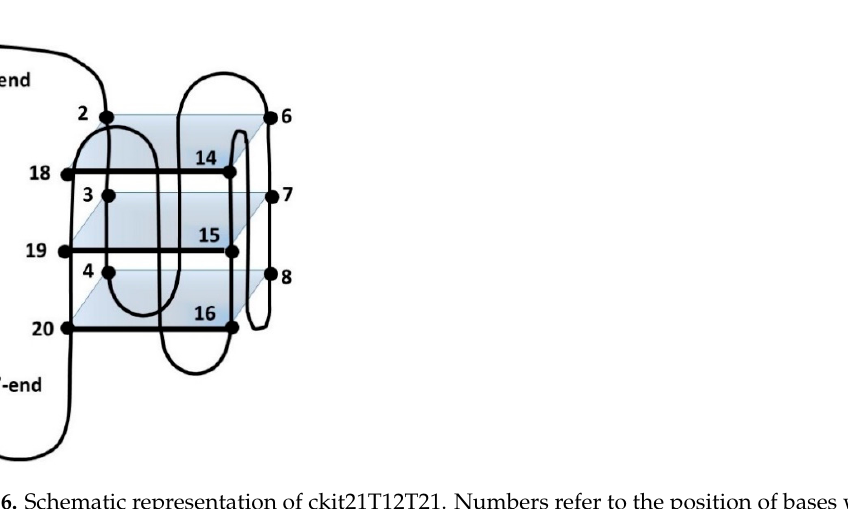
Figure 6. Schematic representation of ckit21T12T21. Numbers refer to the position of bases within this sequence.